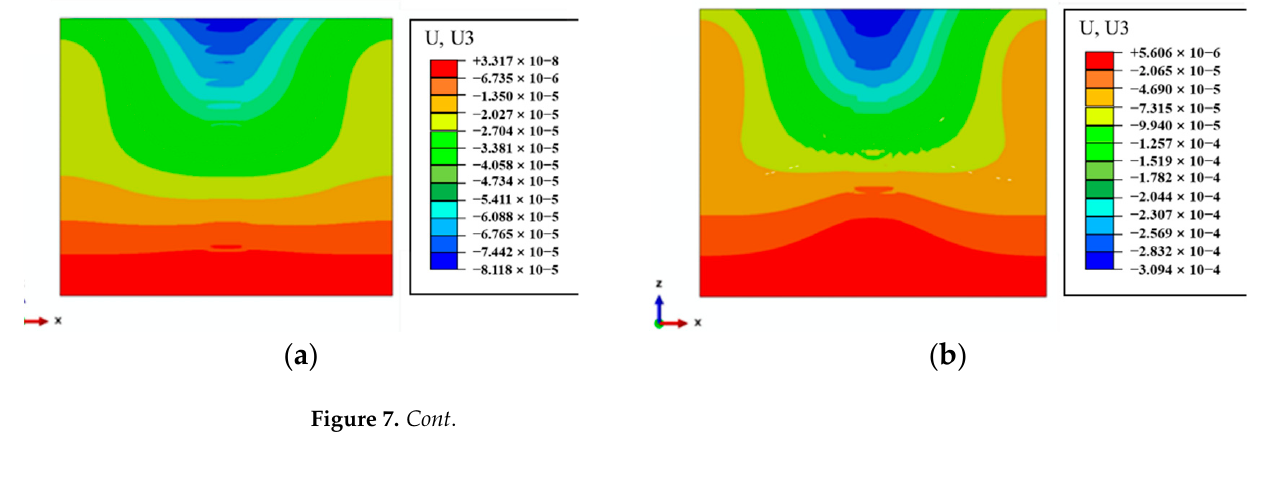
Figure 6. Transverse vertical displacement of the ground surface.